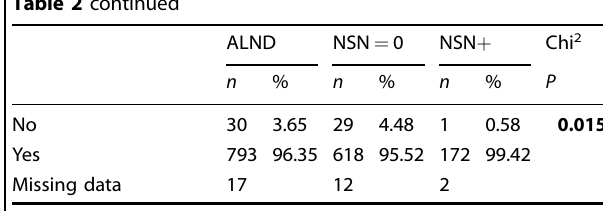
Bold entries indicate statistical signi fi cant differences.